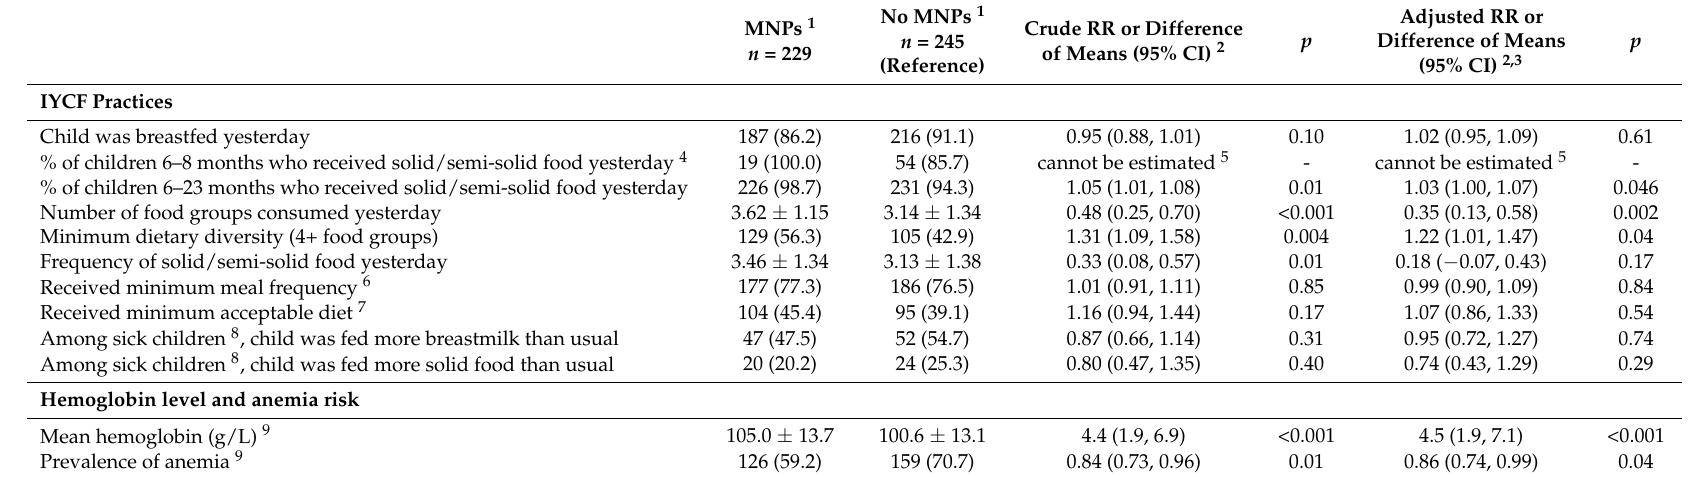
Table 3. Comparing endline nutritional status and IYCF practices among users and non-users of